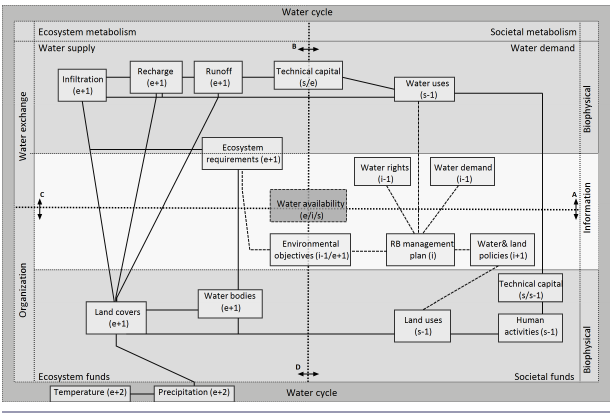
Fig. 3 . Social-ecological system based on the concept of water metabolism (SESWM) analytical framework adapted from Madrid and Giampietro (2015) to the Upper Andarax basin.